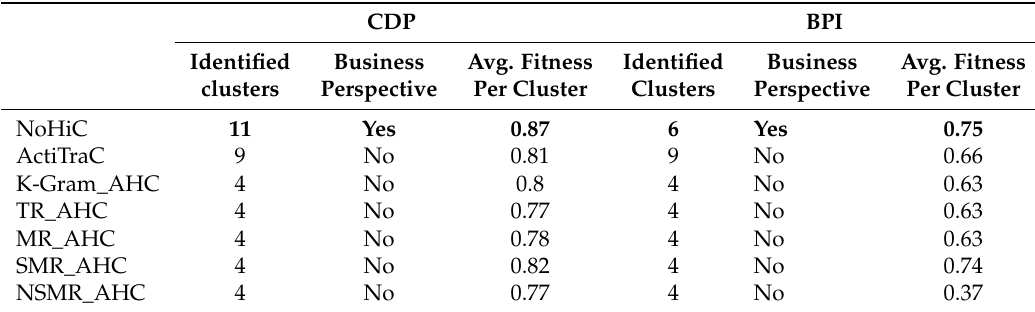
Table 9. Summary of the discovered clusters through NoHiC, ActiTraC and AHC trace clustering